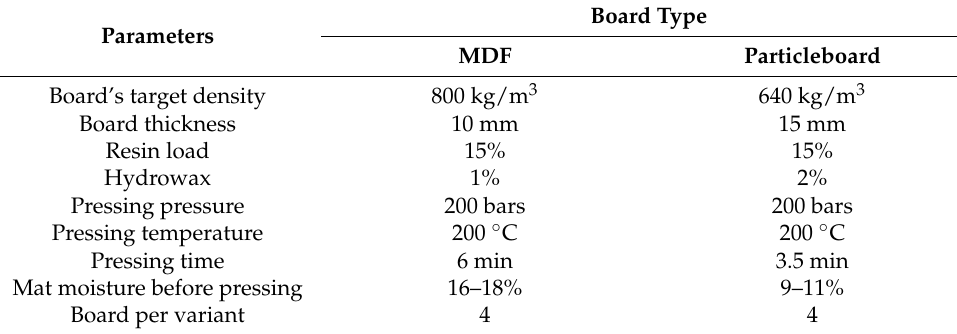
Figure 1. Flowchart for experimental procedure and pictures of some equipment used. Table 2. MDF and particleboard production